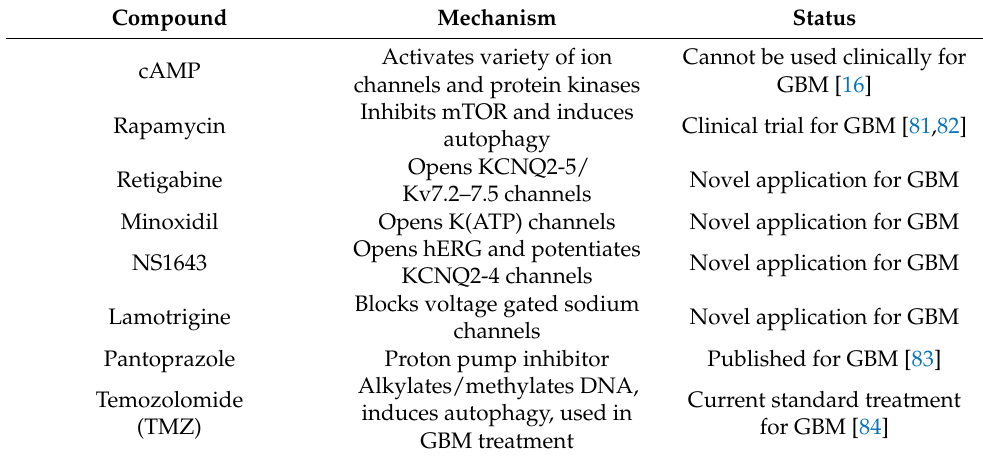
Table 1. Compounds with Highest Efficacy on Proliferation and their Mechanism of Action and